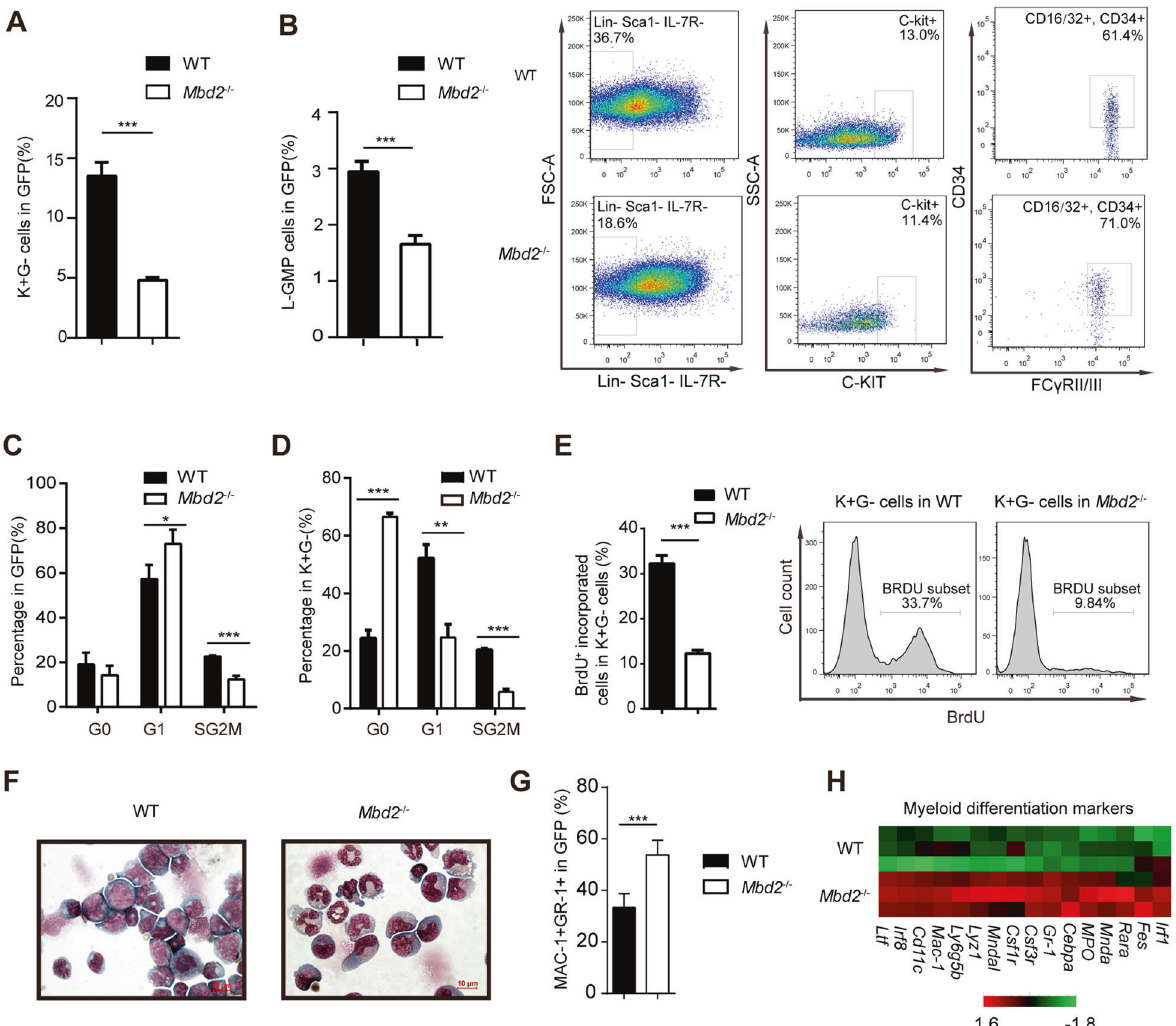
Fig. 3 MBD2 maintains the self-renewal property and inhibits the differentiation of LSCs. A Flow cytometric determination of the percentage of c-Kit + Gr-1 − (K + G − ) cells in the BM of leukemic mice ( n = 5 per group). Error bars, s.d. B Left, Flow cytometric determination of the percentage of L-GMP cells in the BM of leukemic mice ( n = 5 per group). Right, representative FACS plots of L-GMP in the GFP + population. Error bars, s.d. C , D The cell cycle pro fi le of WT or Mbd2 − / − AML GFP + cells ( C ) and K + G − cells ( D ) was determined by fl ow cytometry. Percentages ± s.d. of cells in different cell cycle phases are shown. E The mean percentage ± s.d. values of BrdU + cells are shown within the total K + G − leukemia cells (left panel) and representative histograms (right panel) for the cohort ( n = 5 per group) of Mbd2 − / − versus WT leukemic mice. F Morphology of leukemia cells in BM from either the WT or Mbd2 − / − group. Cells were stained with Wright – Giemsa. Scale bars represent 10 µm. G Flow cytometric determination of the percentage of Mac-1 + Gr-1 + cells (relatively mature/differentiated myeloid cells) among Mbd2 − / − leukemia cells and WT cells. Error bars, s.d. H The expression levels of myeloid differentiation-associated transcripts were determined by qRT-PCR in the indicated cells. Gapdh was included as a loading control. * P < 0.05, ** P < 0.005, and *** P <